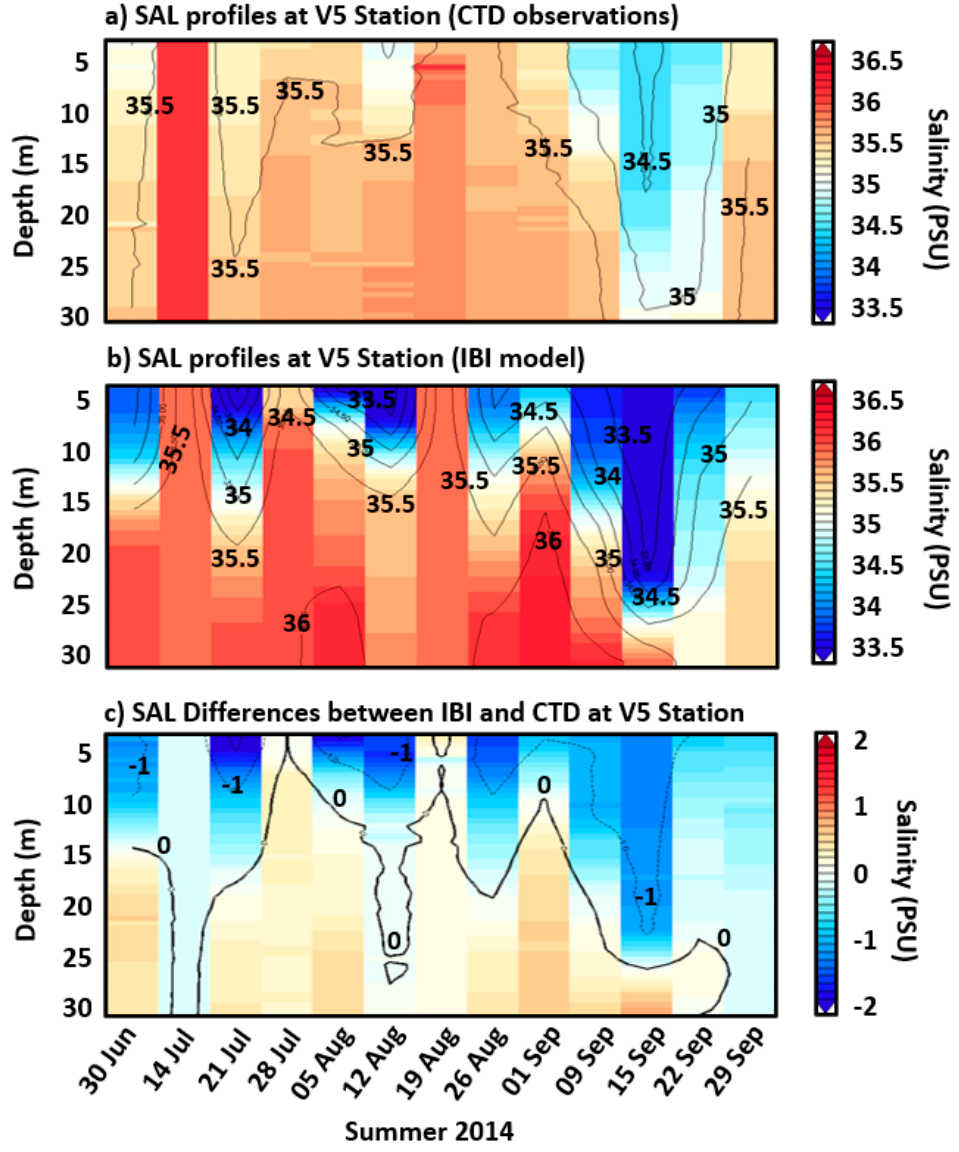
Figure 10. Comparison of salinity (SAL) profiles registered at V5 station (denoted in Figure 1b) by a CDT device ( a ) and IBI model ( b ) at the closest grid point. ( c ) Differences of SAL between the modelled and the observed profiles. Note that this figure is not a Hovmöller diagram but a temporal concatenation of specific dates: Only those CTD in situ observations that successfully fulfilled the quality control have been